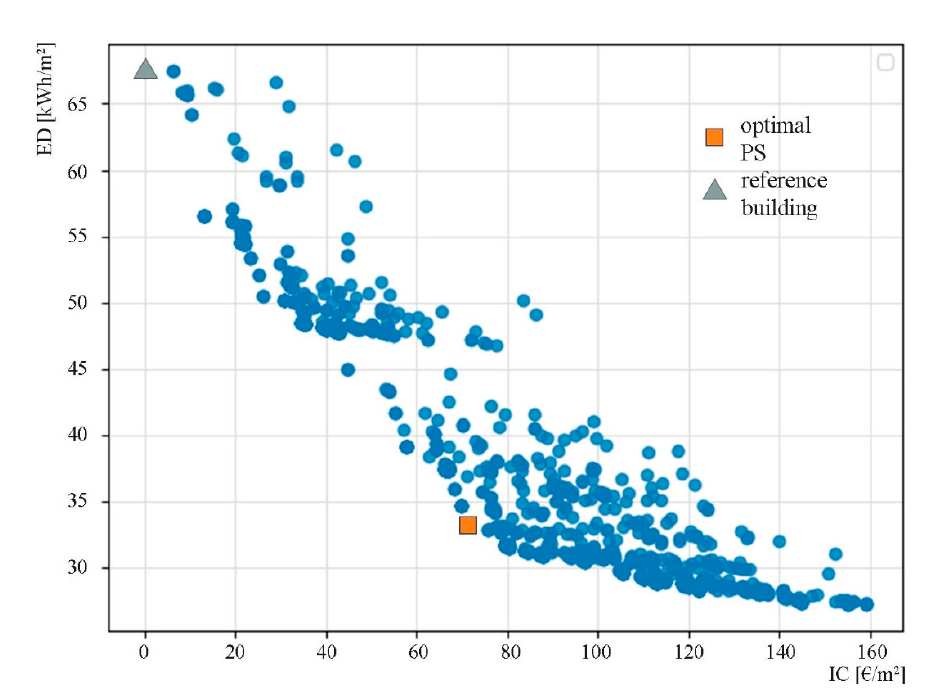
Figure 5. Space of solutions of the multi-objective optimization of passive strategies.